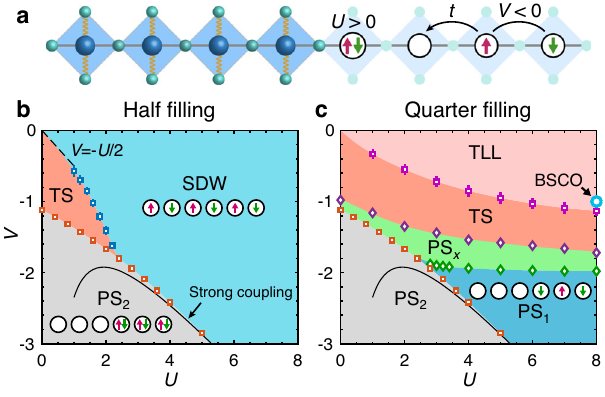
Fig. 1 Extended Hubbard model and phase diagrams. a illustrates the BSCO compound and corresponding extended t - U - V Hubbard model with NN hopping t , on-site repulsive U , and NN attractive V terms. b , c show the quantum phase diagrams of the EHM at half and quarter fi llings, respectively. There are triplet superconducting (TS), spin density wave (SDW), and Tomonaga-Luttinger liquid (TLL) phases. There are also three phase separation phases with singly (PS 1 ) doubly (PS 2 ) or fractionally (PS x ) occupied clusters. The solid black lines represent the asymptotic phase (cid:2) 8ln2 boundary V ¼ (cid:2) U in the strong coupling limit, and the dashed line 2 3 U for V = − U /2 in the weak coupling limit 30,54 . The blue circle in c represents the parameters U = 8 and V = − 1 of the doped 1D cuprate chain BSCO 46